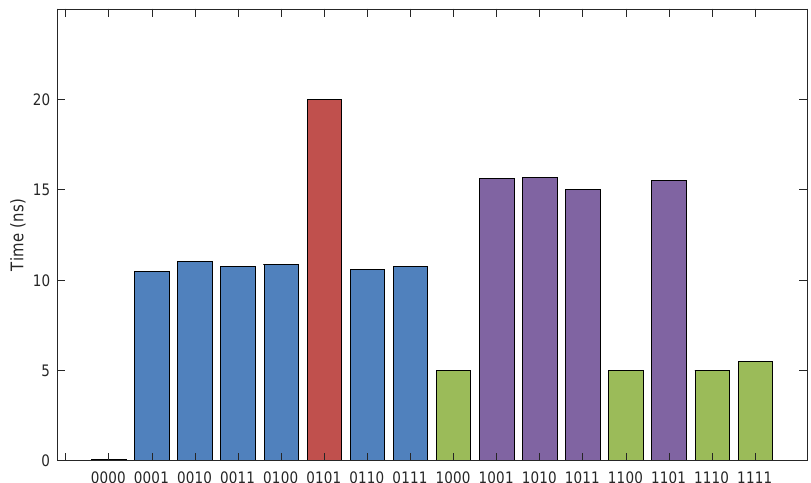
Figure 17. The time of the write